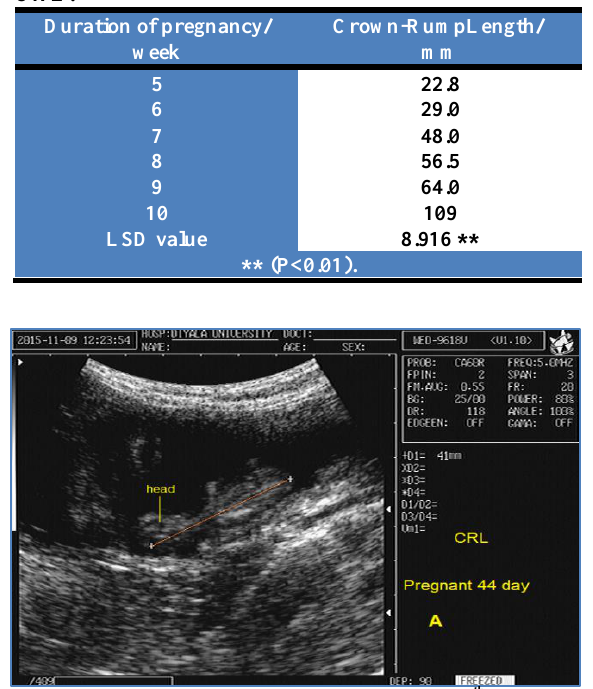
Figure, 1: Measurement of fetal CRL in 6 th week of pregnancy, indicated by straight line, (Sector probe,